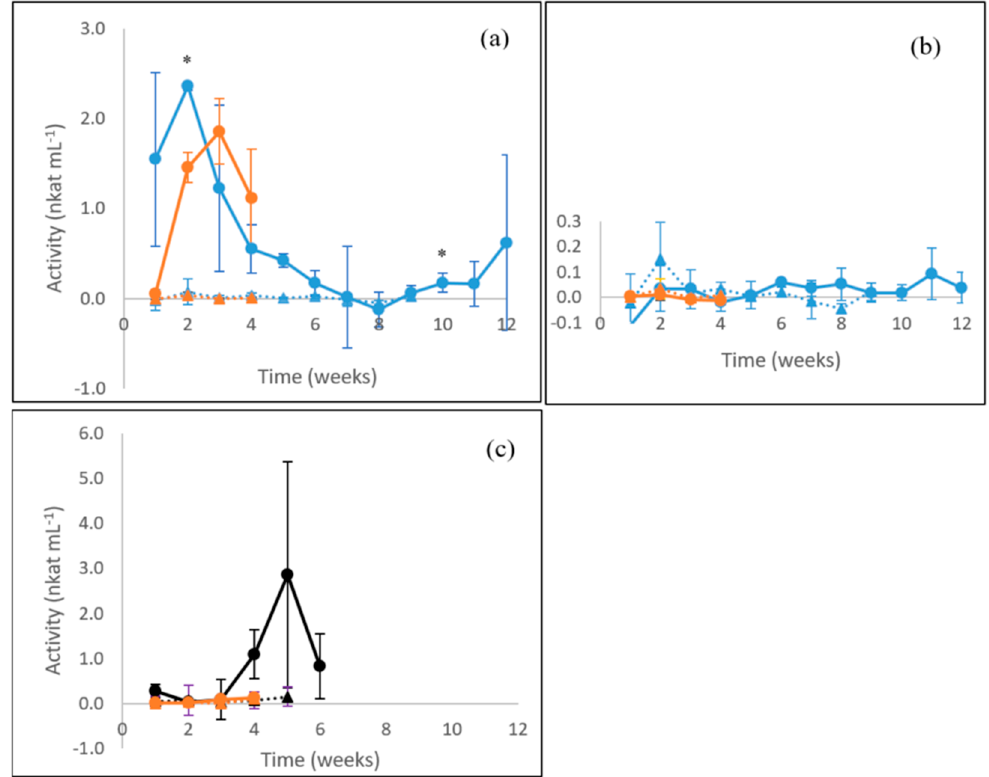
Figure 2. Manganese peroxidase (MnP) activities produced by ( a ) the WR fungus P. radiata ; ( b ) the GR fungus S. commune ; and ( c ) the LDF species C. cinerea . Fungal cultivations on birch wood (blue line with spheres), barley straw (black line with spheres) and liquid ME medium (orange line with spheres). Values from control incubations of birch wood (blue triangles), barley straw (black triangles) and liquid ME medium (orange triangles) without fungi are included. Mean value ( n = 3) is presented at each week time point. Bars indicate the standard error. * statistically significant value between the time points. For information on the fungi, see Table 1.